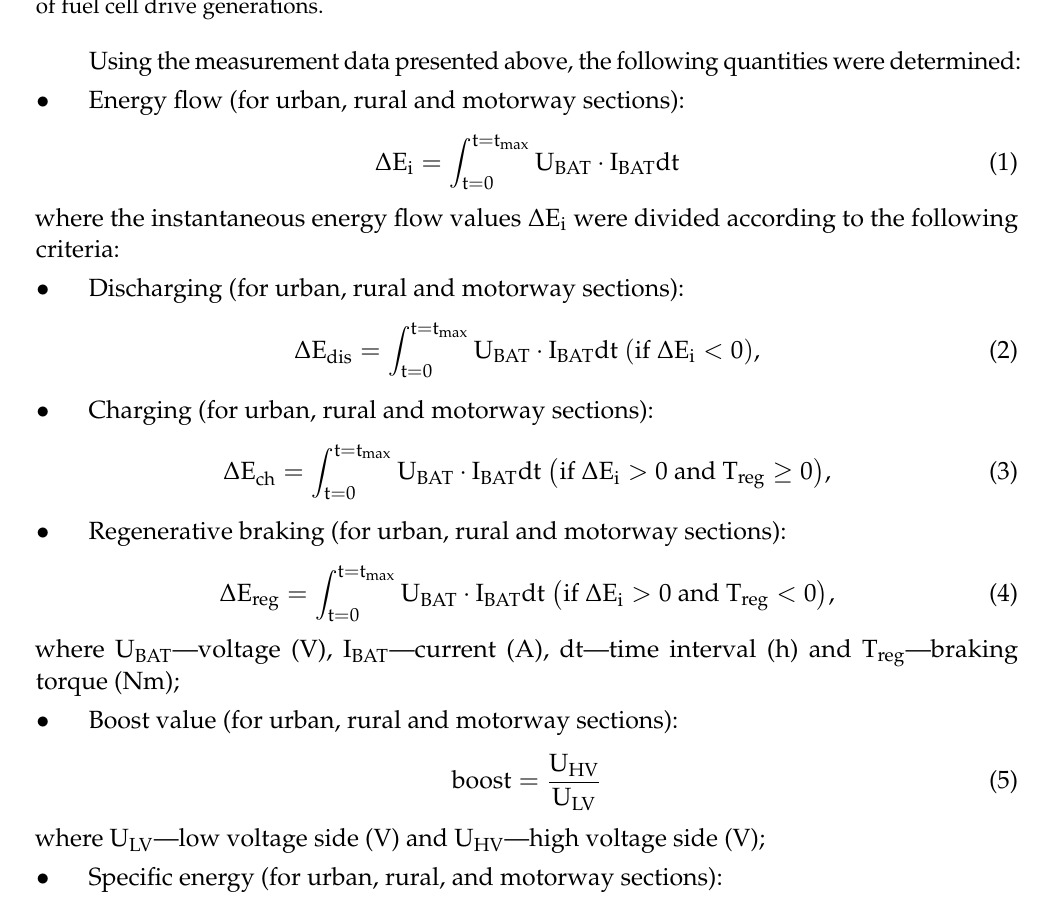
Figure 5. Information flow diagram for the determination of energy flow indicators for the analysis of fuel cell drive generations.